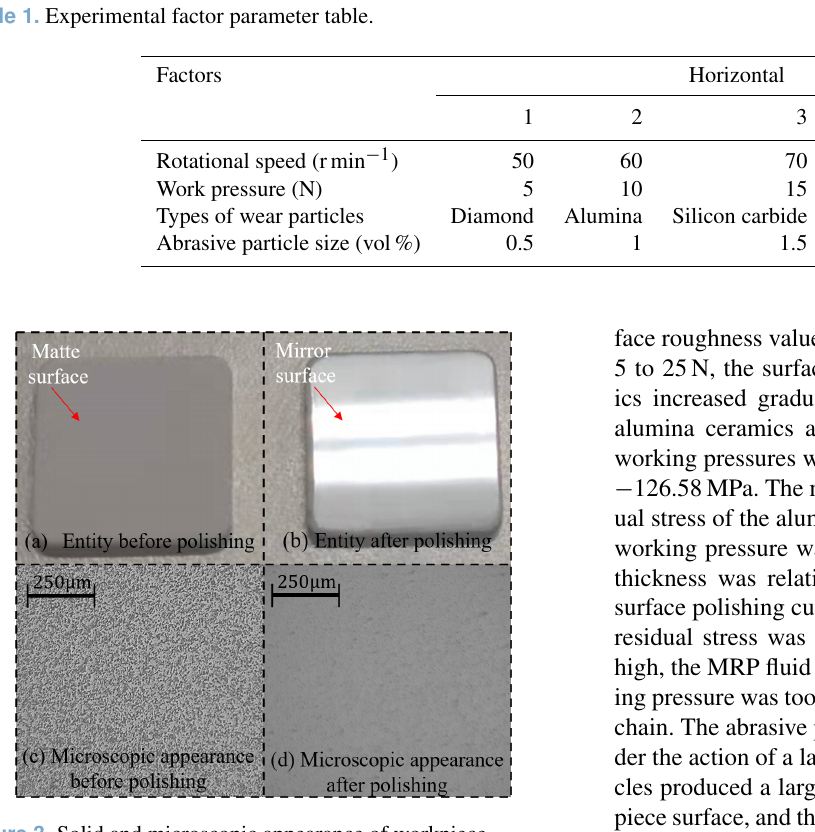
Figure 3. Solid and microscopic appearance of